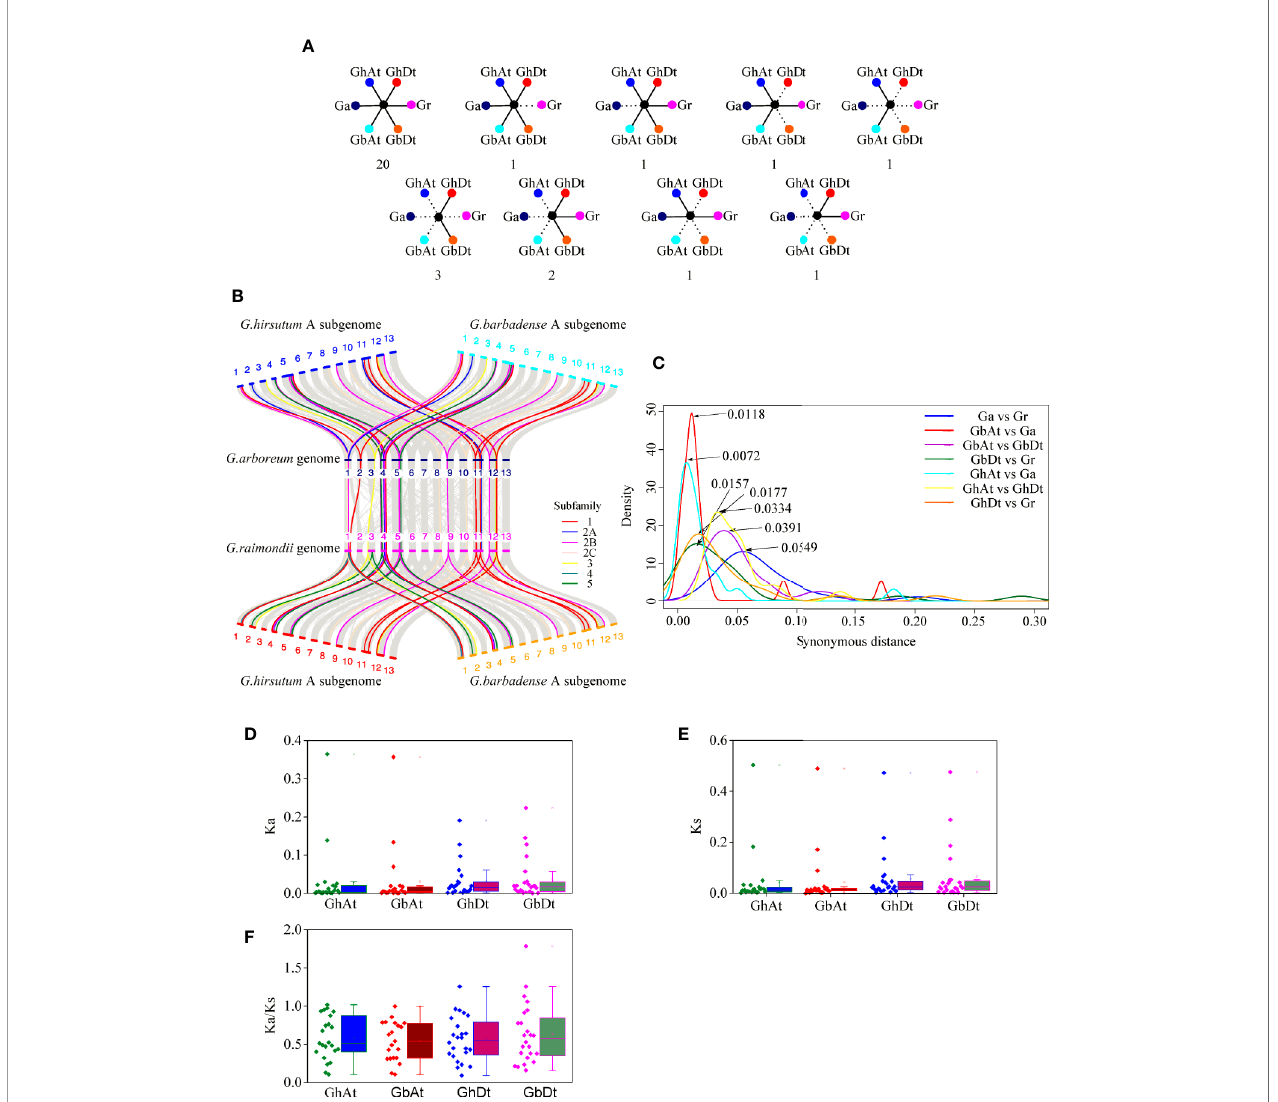
FIGURE 11 | Syntenic and evolutionary analyses of the KUP members of G. hirsutum (GhAt and GhDt), G. barbadense (GbAt and GbDt), G. arboretum (Ga), and G. raimondii (Gr). (A) Scenarios and numbers of the conserved KUPs in cotton. Solid lines represent extant genes, and dotted lines represent lost genes. The numbers beneath each drawing show the number of gene pairs found in four cotton genomes that fi t the corresponding model. From left to right in the fi rst line: KUPs present in all four genomes; KUPs not observed in Gr; KUPs not observed in Ga; KUPs not observed in GhDt and GbDt; and KUPs not observed in GhDt, GbDt, Ga and Gr. From left to right in the second line: KUPs not observed in GhAt, GbAt, Ga, and Gr; KUPs not observed in GhAt, GbAt and Ga; KUPs not observed in GbAt, GbDt, and GhDt; and KUPs not observed in GbAt, GbDt, GhAt, and Ga. (B) Microcollinearity analysis of genomic regions from four cotton species. Gray lines link orthologous gene pairs, and orthologous KUP members from different subfamilies are highlighted with different colored lines. (C) Ks distribution for the orthologous KUP gene pairs of four cotton species. Peak values for each comparison are marked with arrows. Blue, red, purple, dark green, cyan, yellow, and orange lines represent the Ks distribution of the orthologous KUP gene pairs of Ga and Gr, GbAt and Ga, GbAt and GbDt, GbDt and Gr, GhAt and Ga, GhAt and GhDt, and GhDt and Gr, respectively. (D – F) Distribution of Ka values (D) , Ks values (E) , and Ka/Ks ratio (F) between allopolyploid subgenomes and their corresponding ancestral